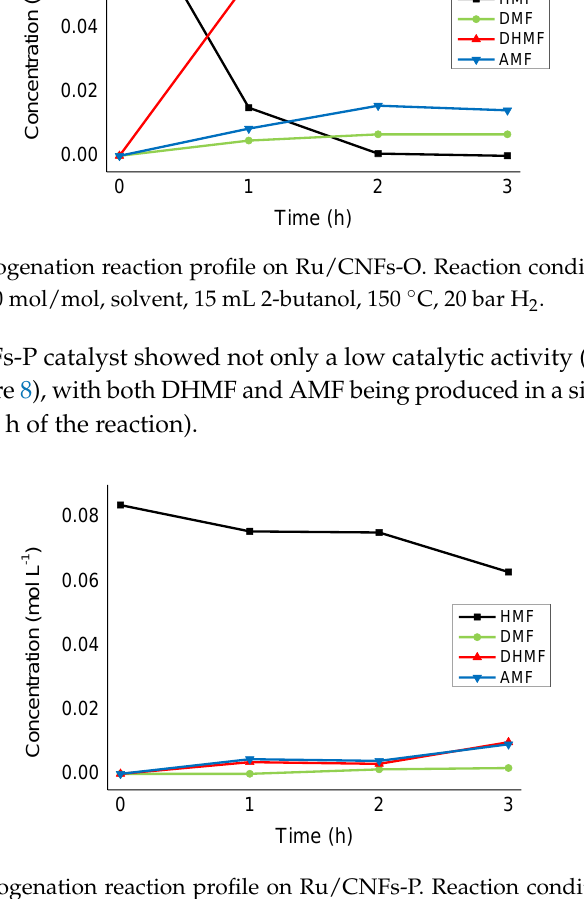
Figure 8. HMF hydrogenation reaction profile on Ru/CNFs-P. Reaction conditions: HMF, 0.08 M, substrate/metal = 100 mol/mol, solvent, 15 mL 2-butanol, 150 °C, 20 bar H 2 .